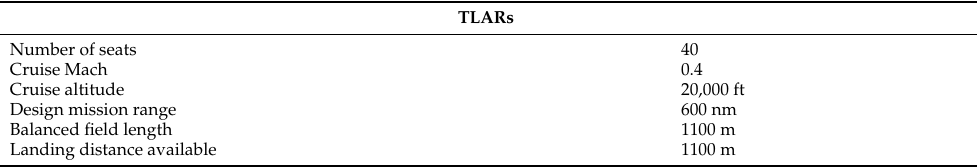
Table 1. Regional aircraft selected TLARs.